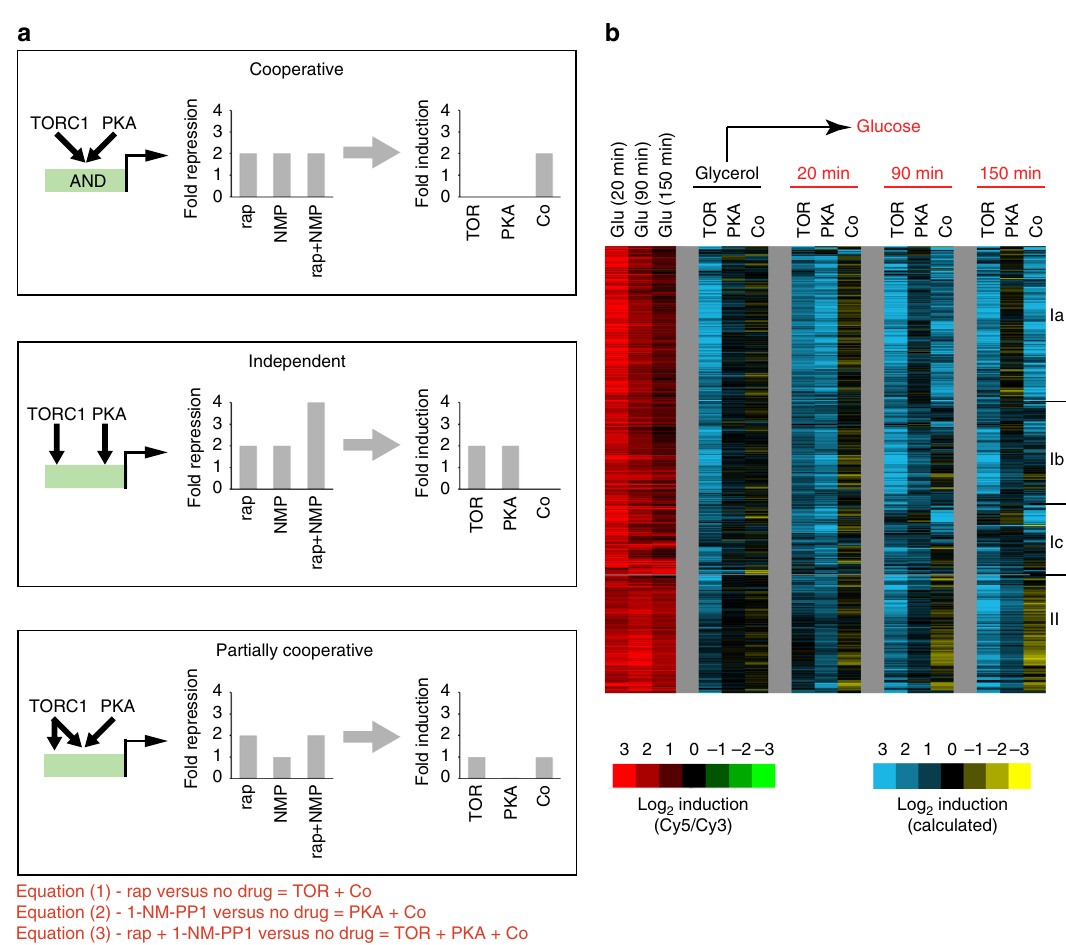
Equation (1) - rap versus no drug = TOR + Co Equation (2) - 1-NM-PP1 versus no drug = PKA + Co Equation (3) - rap + 1-NM-PP1 versus no drug = TOR + PKA + Fig. 3 Expression component analysis. a Expression component analysis was used to determine if, and how, TORC1 and PKA cooperate to regulate gene expression as cells transition from growth in glycerol to growth in glucose. To see how expression component analysis works it is useful to compare three possible scenarios. In the fi rst scenario (upper panel), the TORC1 and PKA kinases are both absolutely required for activation of a particular gene. In this case, the expression defect in rapamycin (due to TORC1 inhibition) is equal to the expression defect in 1-NM-PP1 (due to PKA inhibition) and the expression defect in rapamycin + 1-NM-PP1 (due to TORC1 and PKA inhibition). Solving Eqs. (1 – 3), then leads us to a positive Co component and no TOR or PKA component. In the second scenario (middle panel), the TORC1 and PKA kinases act independently (in parallel) to activate the same gene, leading to a positive TORC1 and PKA component, but no Co component (Co = 0). Finally, in the third scenario (lower panel), the TORC1 and PKA kinases act cooperatively to activate the same gene (for example, if both factors phosphorylate and activate a single transcription factor) but TORC1 also activates the gene through a separate mechanism, leading to positive TORC1 and Co components, but no PKA component (PKA = 0). Expression component analysis can also be used to identify other modes of regulation, including redundancy (OR gating) where the Co component has a negative value 28,29 . b Expression component analysis of TORC1 and PKA signaling in glycerol and glucose medium. The fi rst three columns in the heat map show the raw expression data for the ribosome and protein synthesis genes (Groups I and II), taken from Fig. 1. The remaining columns show the expression components calculated using the rapamycin, 1-NM-PP1, and rapamycin + 1-NM-PP1 data listed in Supplementary Data fi le and the equations listed in part (a), as explained in the text. Groups I a, b, and c were de fi ned by clustering the expression component data for Group I from Fig. 1. All experiments shown here have been repeated at least twice, leading to near identical expression component